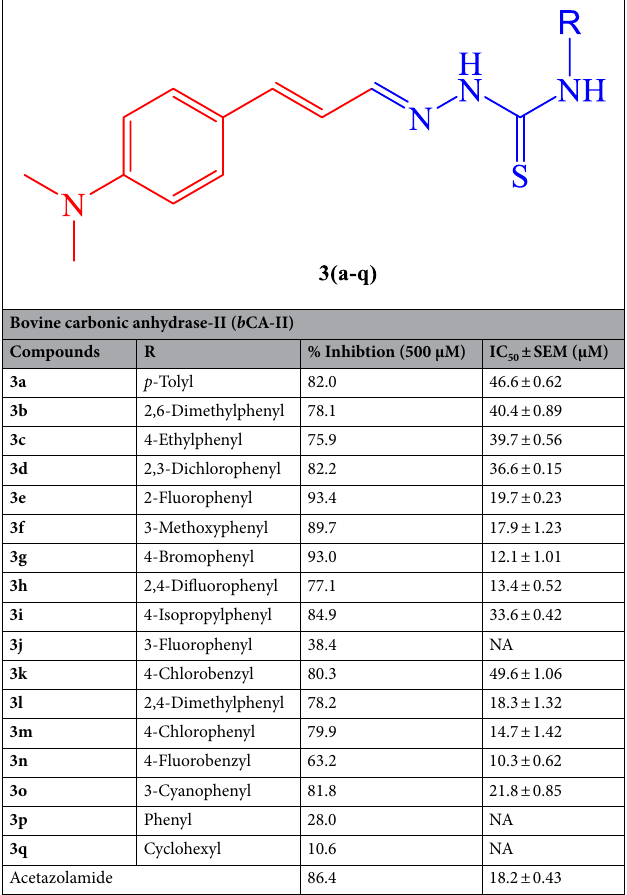
Table 1. In vitro b CA-II inhibition values of synthesized compounds ( 3a–q ) .